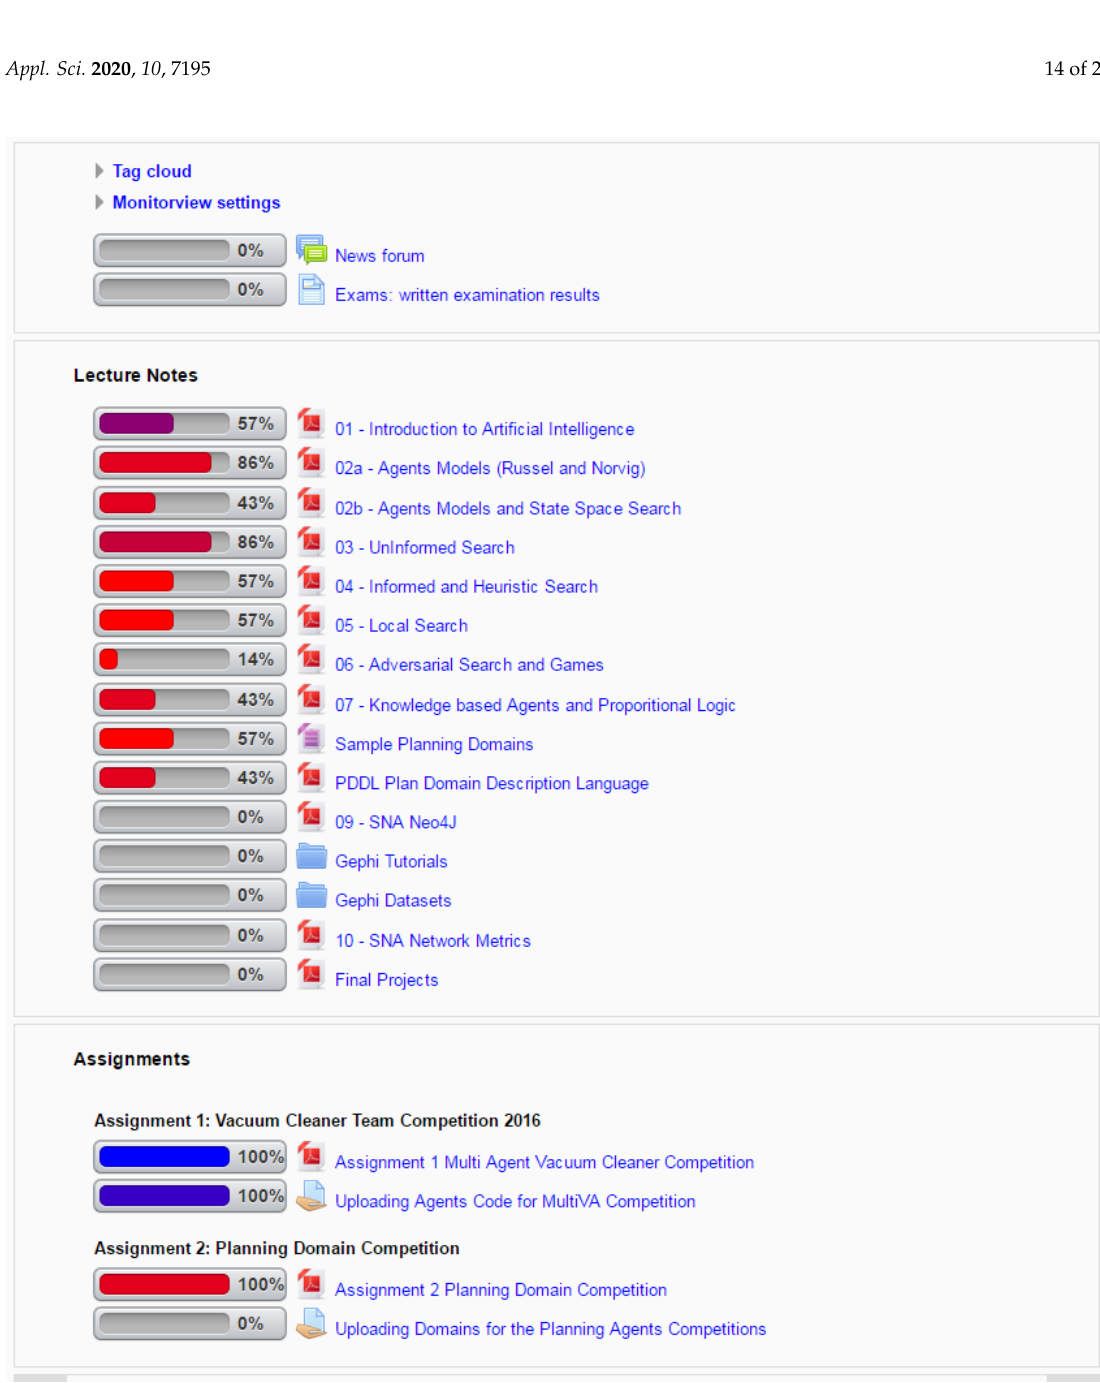
Figure 7. Course statistics in Thermometer bar